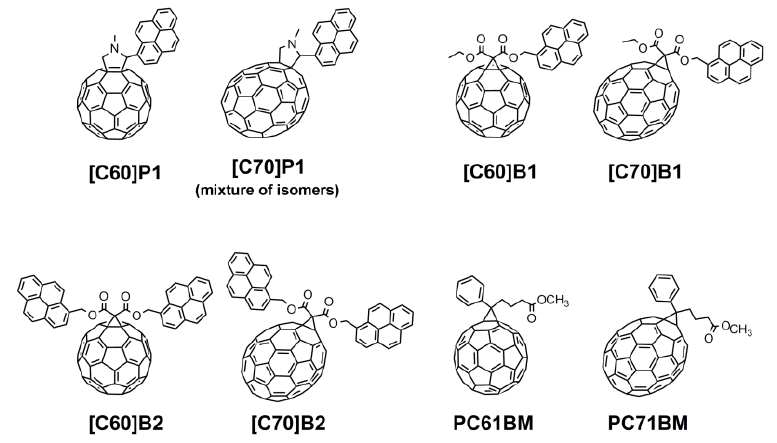
Figure 1. Structures of investigated C 60 and C 70 fullerene–pyrene derivatives (in the case of [C70]P1 only structure of one of the possible isomers is shown; in performed experiments mixture of all synthesized isomers was used).